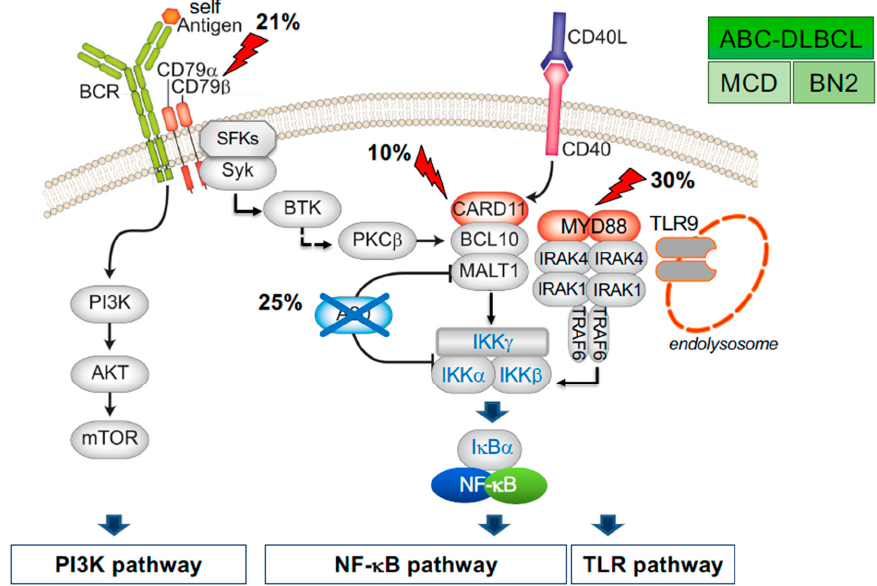
Figure 3. BCR-dependent constitutive activation of the canonical NF- κ B signaling pathway in ABC-DLBCL. Genetic aberrations enforcing constitutive activation of the NF- κ B signaling cascade downstream of the BCR, CD40 receptor, and TLR9 are a genetic hallmark of ABC (MCD/C5 and BN2) DLBCL. Direct targets of genetic lesions are shown in shades of blue (inactivation) and red (dereg- ulated expression/activity), with symbols depicting gain-of-function and loss-of-function events. Percentages refer to ABC-DLBCL overall. This constellation of genetic events is also frequently ob- served in primary central nervous system lymphoma, PCNSL, and Waldenstr ö m macroglobuline- mia. Note that, in the CBM complex, PKC β directly phosphorylates CARD11. The putative normal counterpart of GCB-DLBCL is unquestionably a GC B cell [7] that is undergoing somatic hypermutation of its rearranged Ig genes [87] and depends on